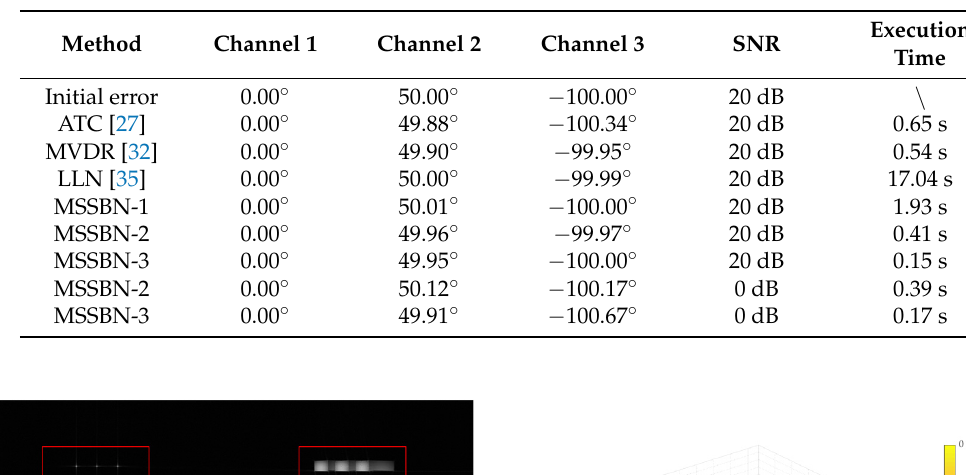
Table 4. Channel phase imbalance estimation results.